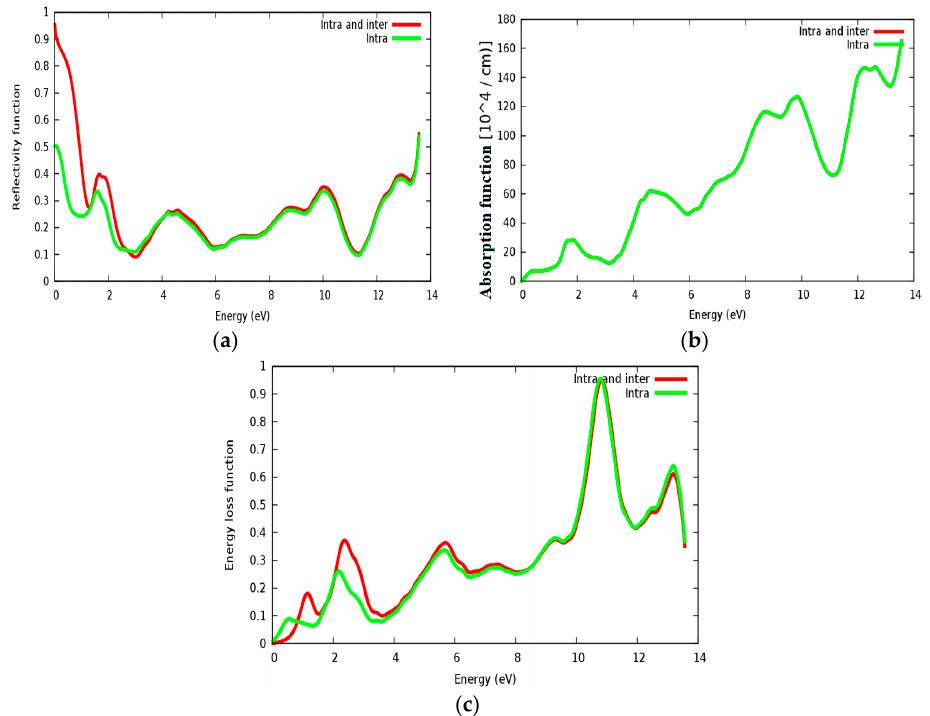
Figure 13. ( a ) Reflectivity function R ( ω ); ( b ) absorption function; and ( c ) energy loss function L ( ω ) for SrRhO 3 compound.